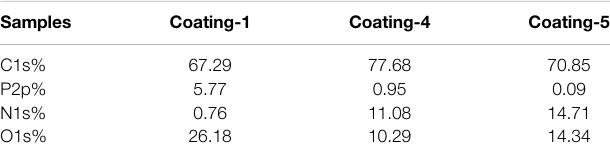
TABLE 4 | XPS results of char residues of different coatings.